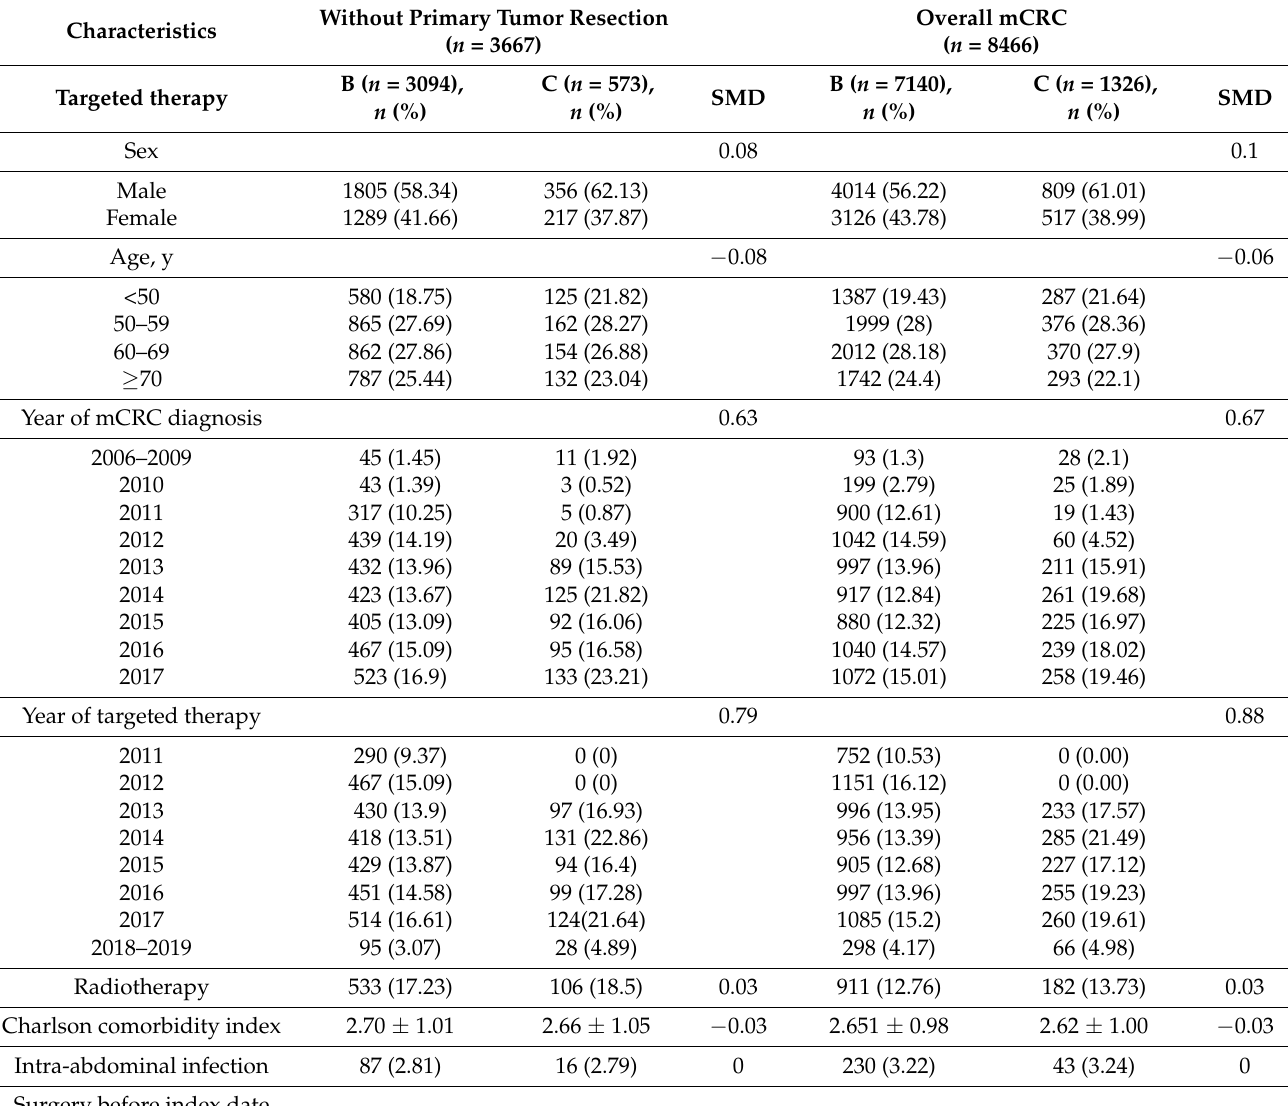
Table 1. Baseline characteristics of patients with mCRC who did not undergo primary tumor resection before targeted